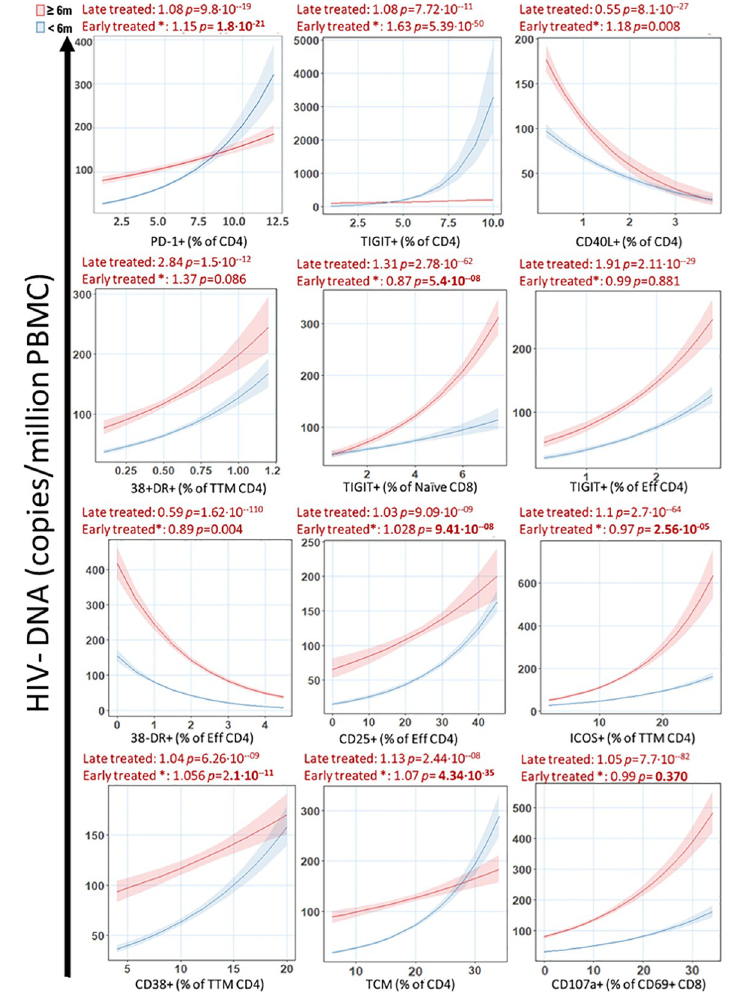
Fig 3. Predictors of HIV-1 DNA reservoir in participants treated before or after 6 months of age. After dividing the cohort in participants treated before 6 months of life (Blue) or after 6 months of life (Red), Predictors identified by penalized regression were plotted against predicted outcome (HIV-DNA) as in Fig 2. A value of effect above 1 indicates a positive contribution while a value between 0 and 1 indicates a negative contribution. � : effect of the association between the parameter and the reservoir when early treated compare to the late